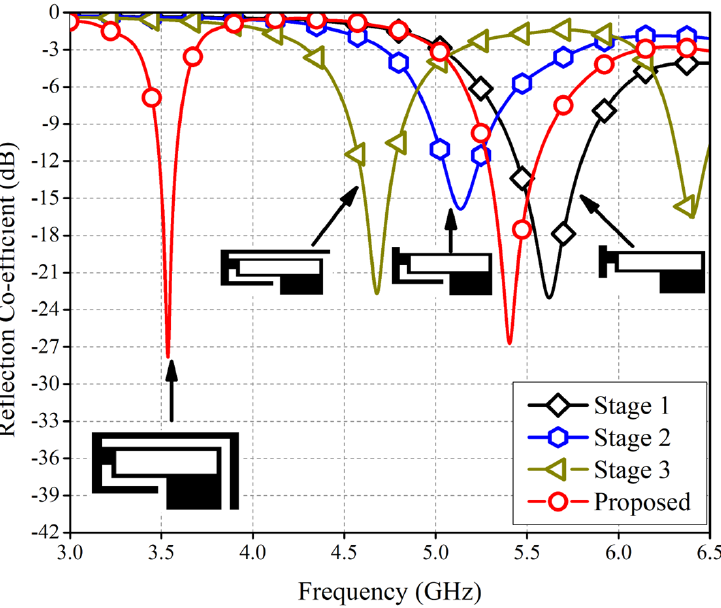
Figure 2. Design evolution of the proposed single antenna element.